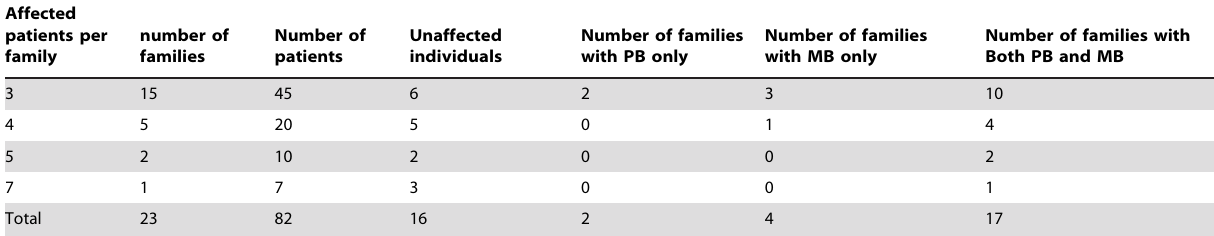
Table 2. Family structures for 23 leprosy